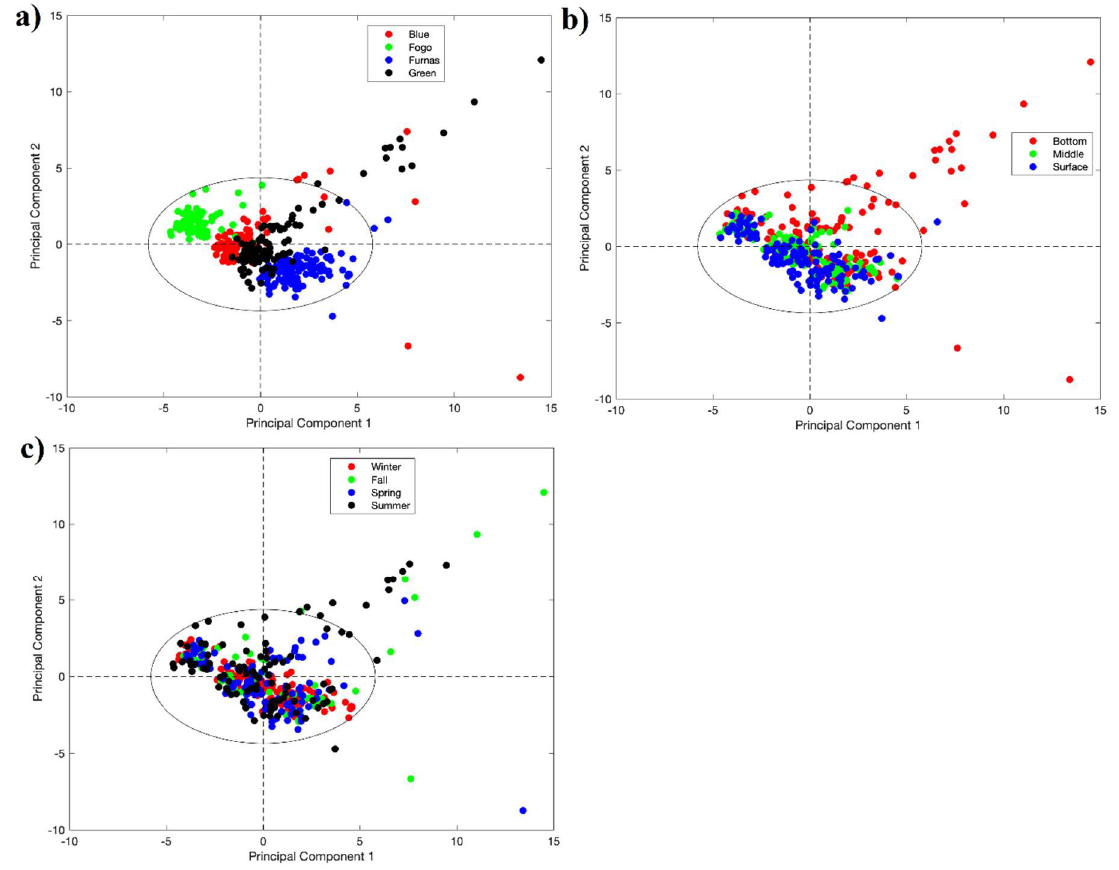
Figure 7. Biplots for the multivariate analysis of physicochemical data, colored according to lakes ( a ), depth ( b ) and season ( c ).